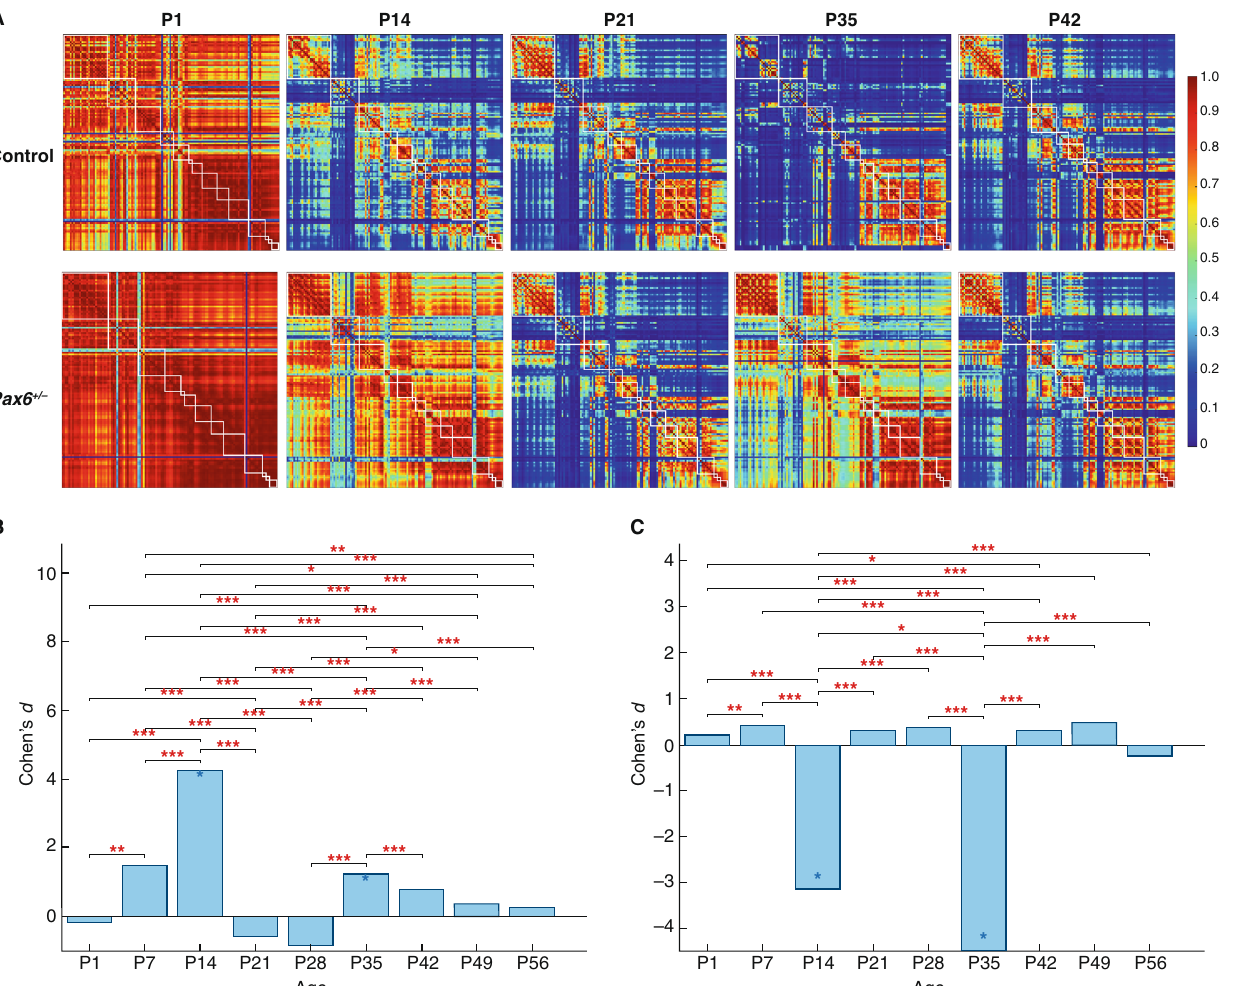
Fig. 5 | Brain synaptome architecture is transiently disrupted in Pax6 +/ − mice. A At the indicated ages in control and Pax6 +/ − mice we compared the similarity of the synaptome between pairs of brain subregions (rows and columns) (see Fig S2 for all ages and high-resolution graphs). White boxes indicate the subregions that belong to the same main brain region (see region list in Supplementary Data 1). Scalebar,similarityvalues. B Differences(Cohen ’ s d )inthesimilarityratiobetween Pax6 +/ − and control mice for the different age groups. A signi fi cant increase in similarityratioisseenin Pax6 +/ − miceatP14andP35:blueasterisk P <0.05,Bayesian test with Benjamini – Hochberg correction. The difference in the similarity ratio at P14 is signi fi cantly larger than at other ages: red asterisks, * P <0.05, ** P <0.01,